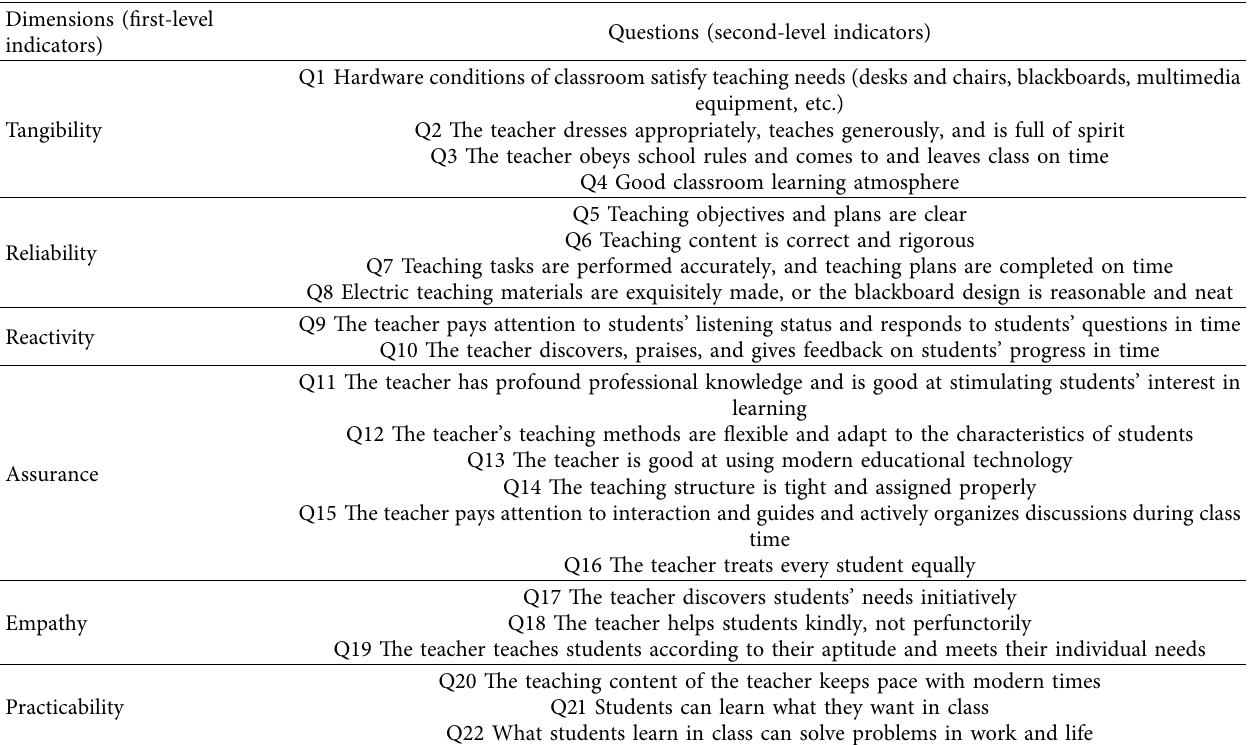
Table 1: Initial indicators of survey on Haizhi students’ classroom satisfaction.